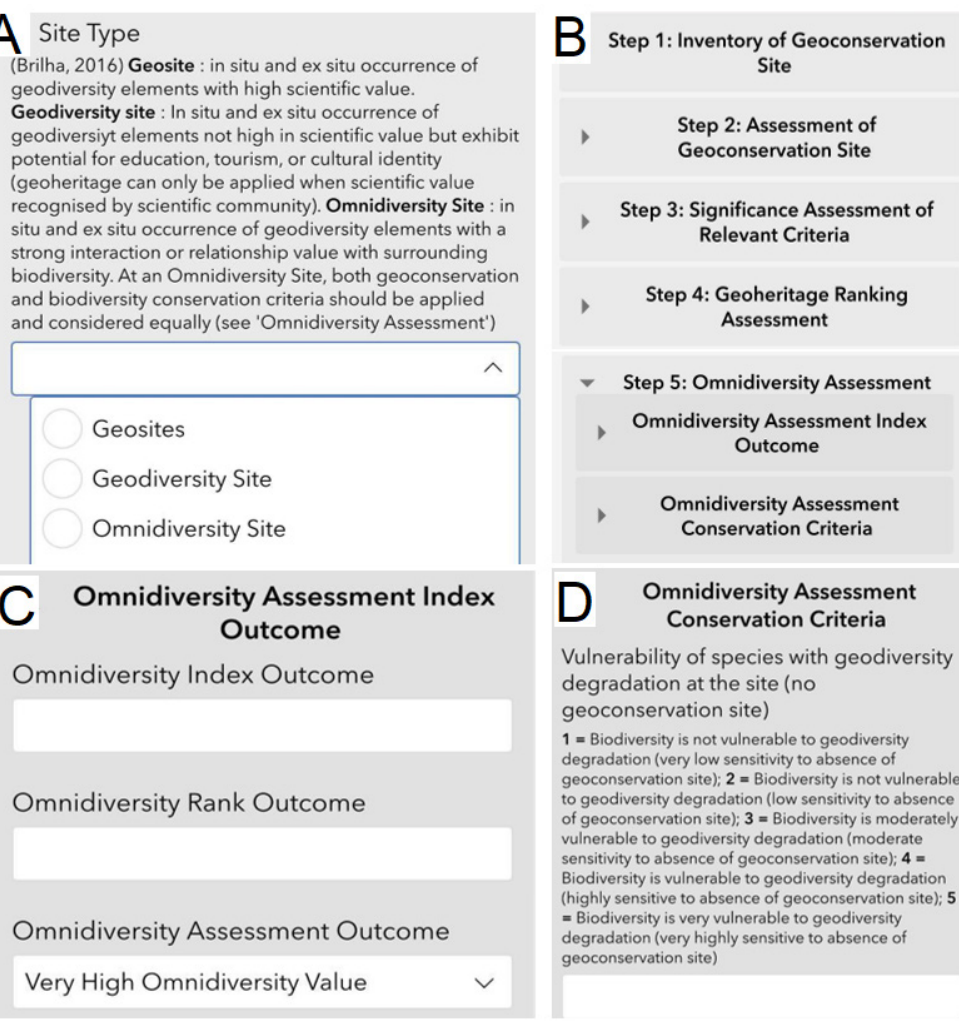
Figure 3. The user interface of the omnidiversity approach adapted in Survey 123. A) Step one of the geocon- servation strategy prompting population of site type. B) The five separate steps to implement each stage of the geoconservation strategy and consolidation assessment criteria. C) Interface for assessment index, assessment ranking tool, and overall assessment outcome. D) Interface for assessment outcome criteria to determine final value for overall assessment outcome at the